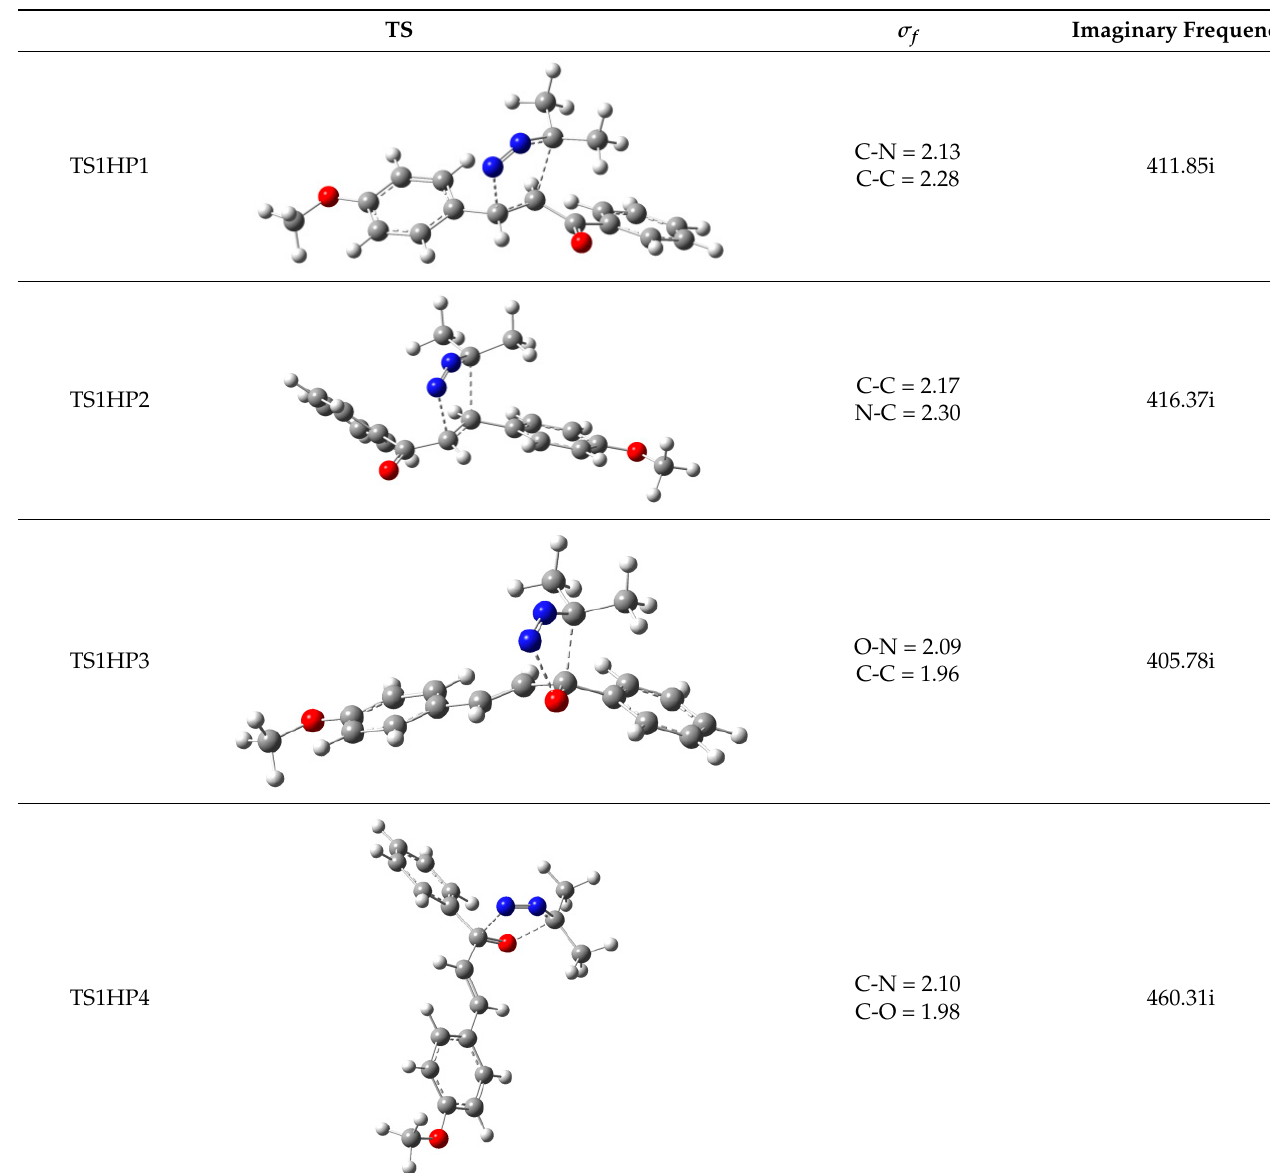
Table 2. Figures of computed transition states TS1-4H and computed of the new formed bond lengths